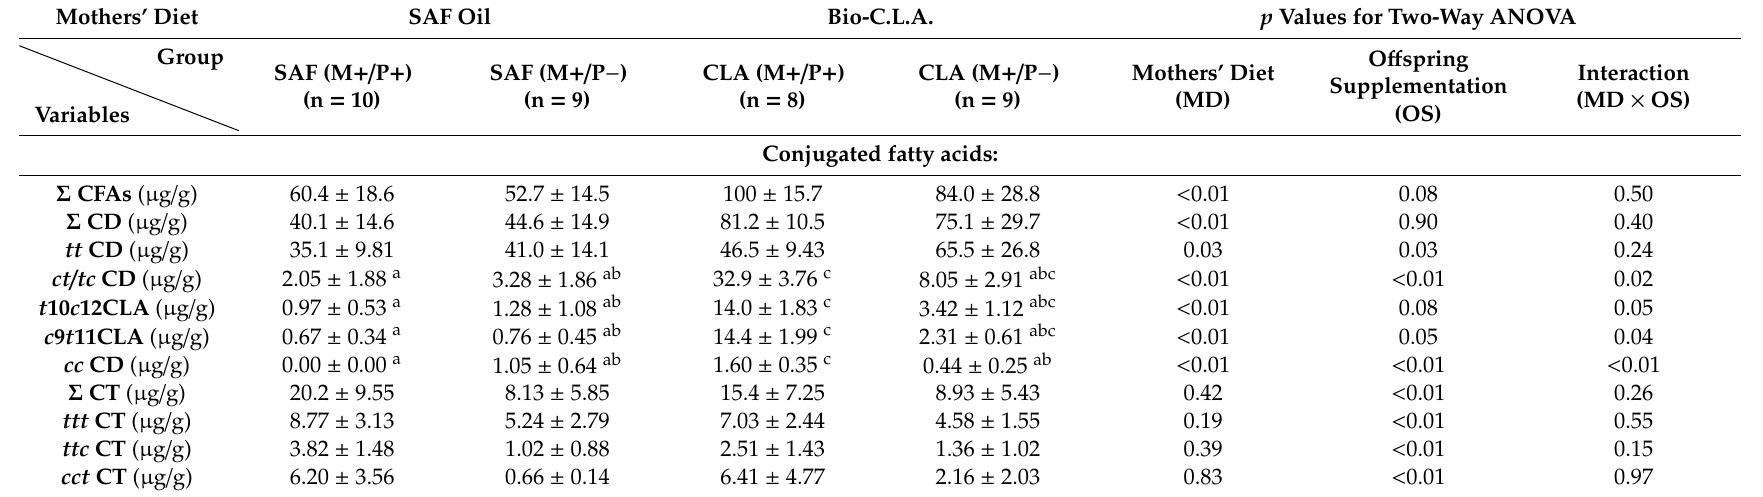
Table 3. Profile of conjugated fatty acids (CFA) in the hearts of o ff spring of mothers supplemented with sa ffl ower oil (SAF oil) or Bio-C.L.A., in whom supplementation with the same preparation was continued (SAF(M +/ P + ); CLA(M +/ P + )) or not (SAF(M +/ P − ); CLA(M +/ P − )). Mothers’ Diet SAF Oil Bio-C.L.A. p Values for Two-Way ANOVA Group O ff spring SAF (M +/ P + ) SAF (M +/ P − ) Mothers’ Diet Interaction Supplementation (n = 10) (n = 9) (MD) (MD × OS) (OS) Variables Conjugated fatty acids: